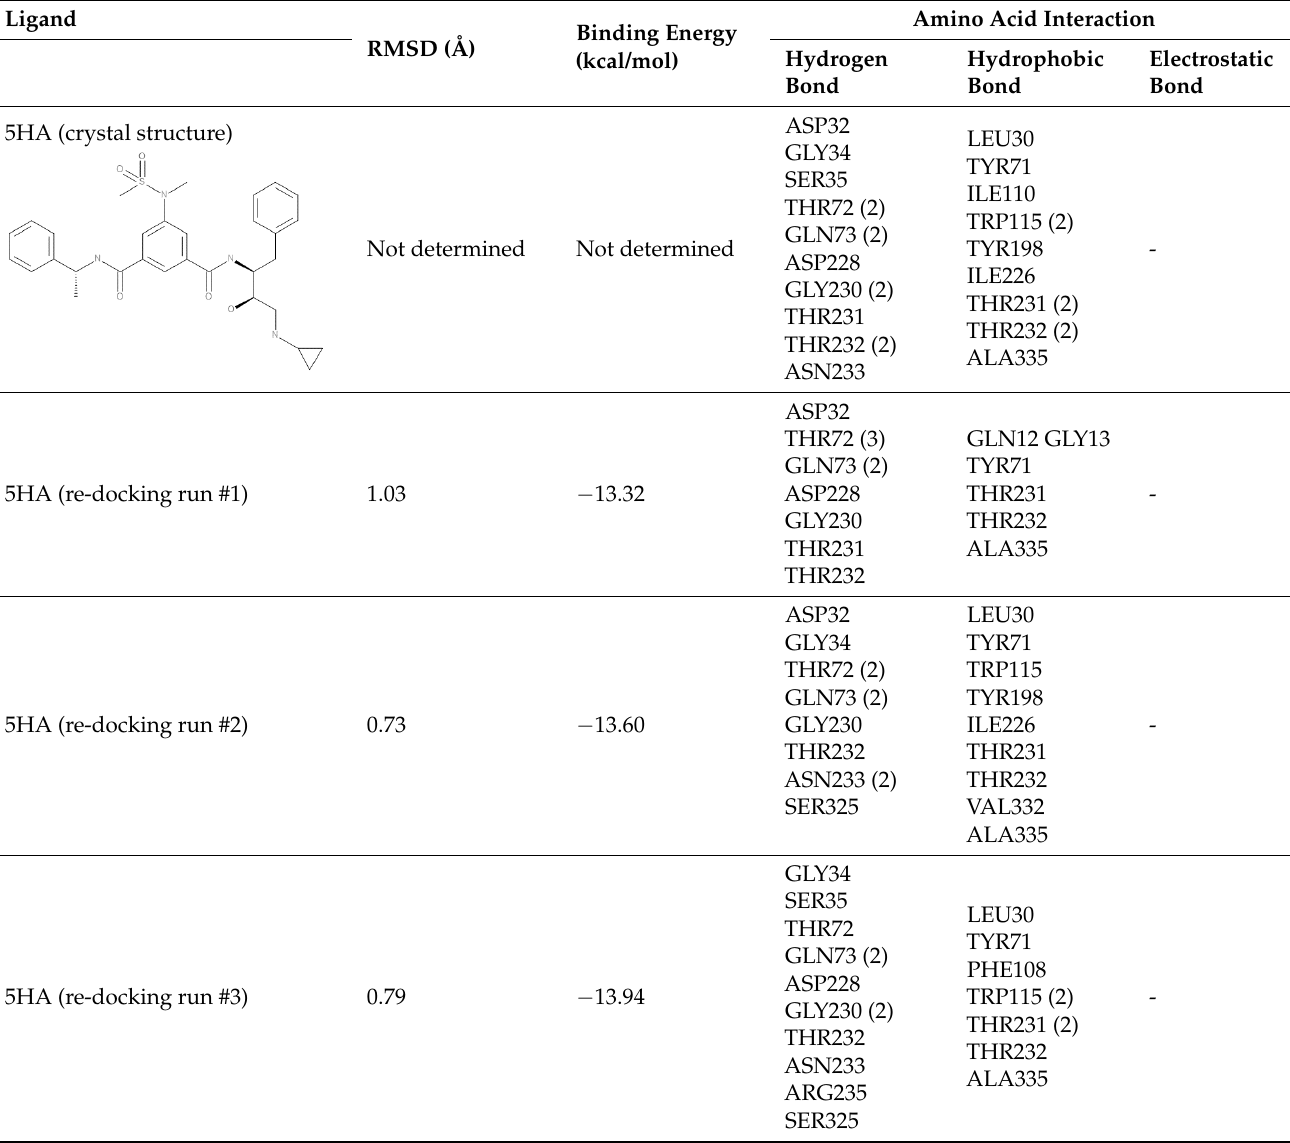
Table 1. The results of method validation between co-crystalized ligand (5HA) at the original active site of BACE1 (PDB ID: 3TPP).